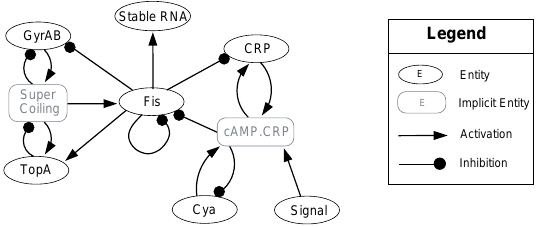
Figure 4: High-level regulatory network for the carbon starvation response network in E. coli